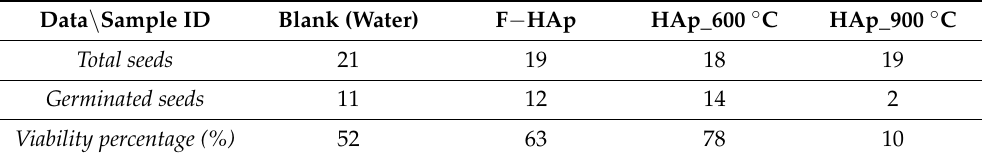
Table 8. Germination viability for watercress seeds exposed to Co-adsorbed HAp obtained from fishery